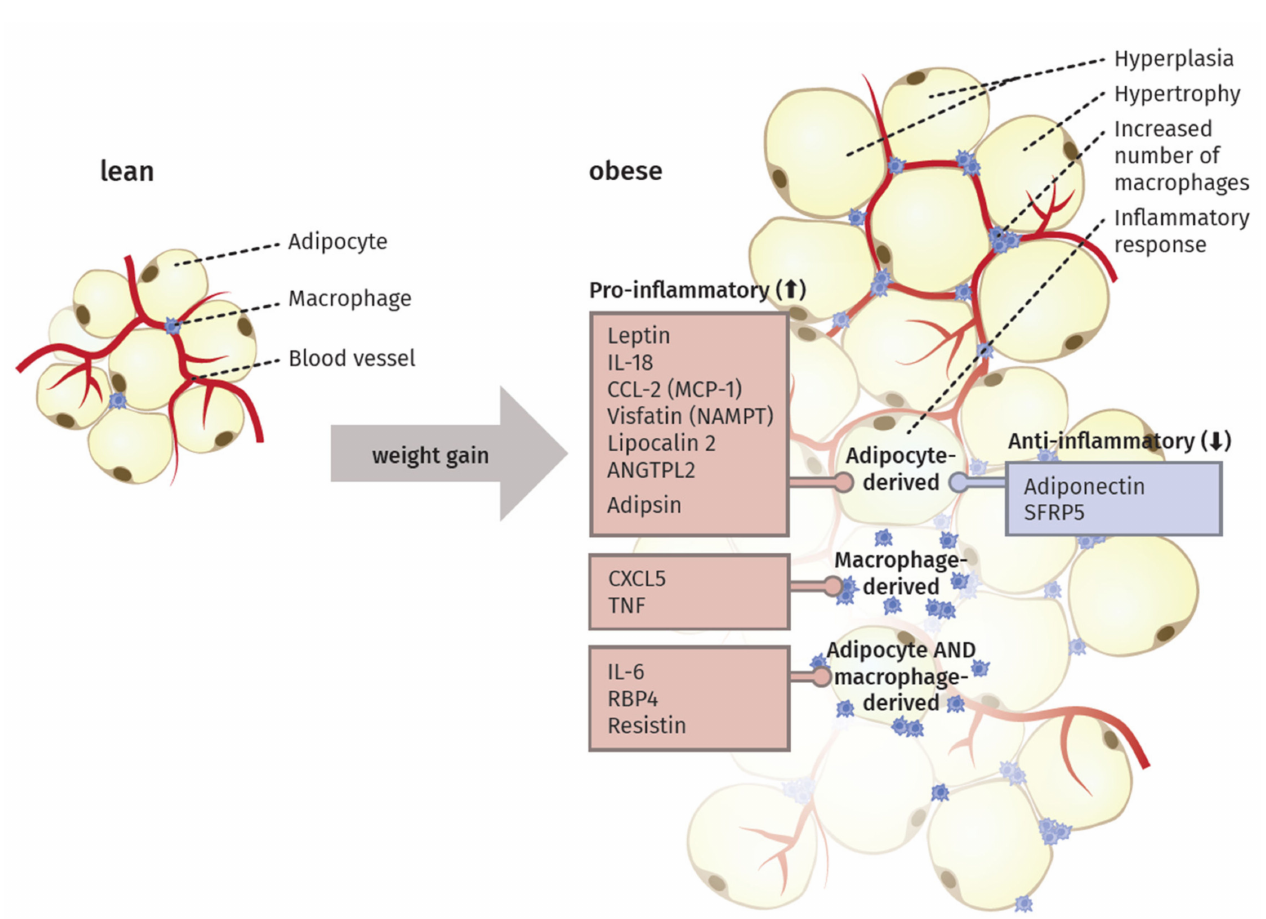
Figure 1. The remodeling process in adipose tissue during weight gain. White adipose tissue is primarily composed of adipocytes, macrophages and blood vessels. To cope with an elevated amount of triacylglycerols (TG) during weight gain, adipocytes increase in size (hyperplasia) and number (hypertrophy). This can further result in the apoptosis of adipocytes, chemotactic regulations, hypoxia and free fatty acids. All four mechanisms are discussed to foster the heightened migration of macrophages into the adipose tissue. Moreover, the secretions of different adipocytokines, produced in adipocytes, macrophages or in both cell type, are influenced. In general, anti-inflammatory secretory products are downregulated, whereas the secretion of pro-inflammatory adipocytokines is elevated. These developments provide a low-grad pro- inflammatory environment, which arises from the increased and remodeled adipose tissue in obese